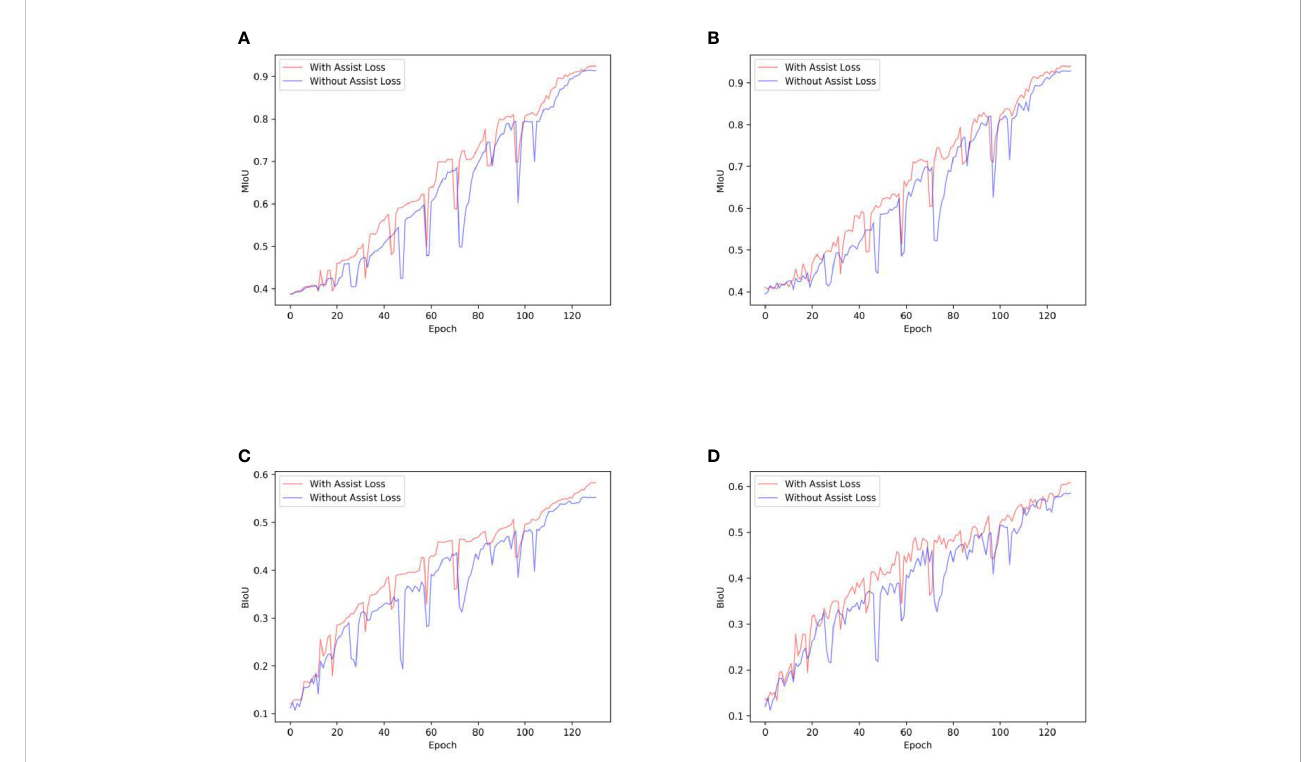
FIGURE 9 The effects of assistant supervision: (A, C) represent the changing trends of MIoU and BIoU in training from scratch, (B, D) are the changing trends of MIoU and BIoU in fi ne-tuning